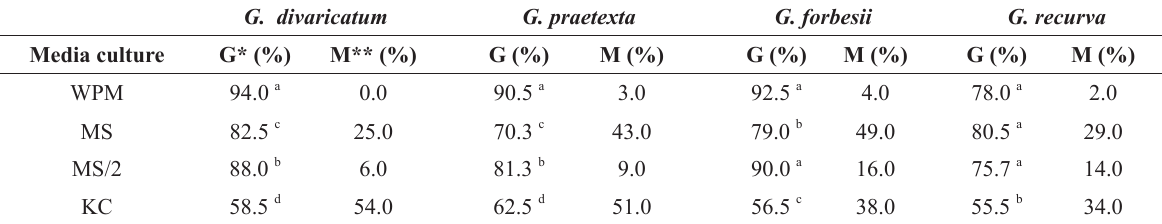
Germination and mortality percentage for Grandiphyllum divaricatum, Gomesa praetexta, Gomesa forbesii and Gomesa recurva in different saline compositions, after 60